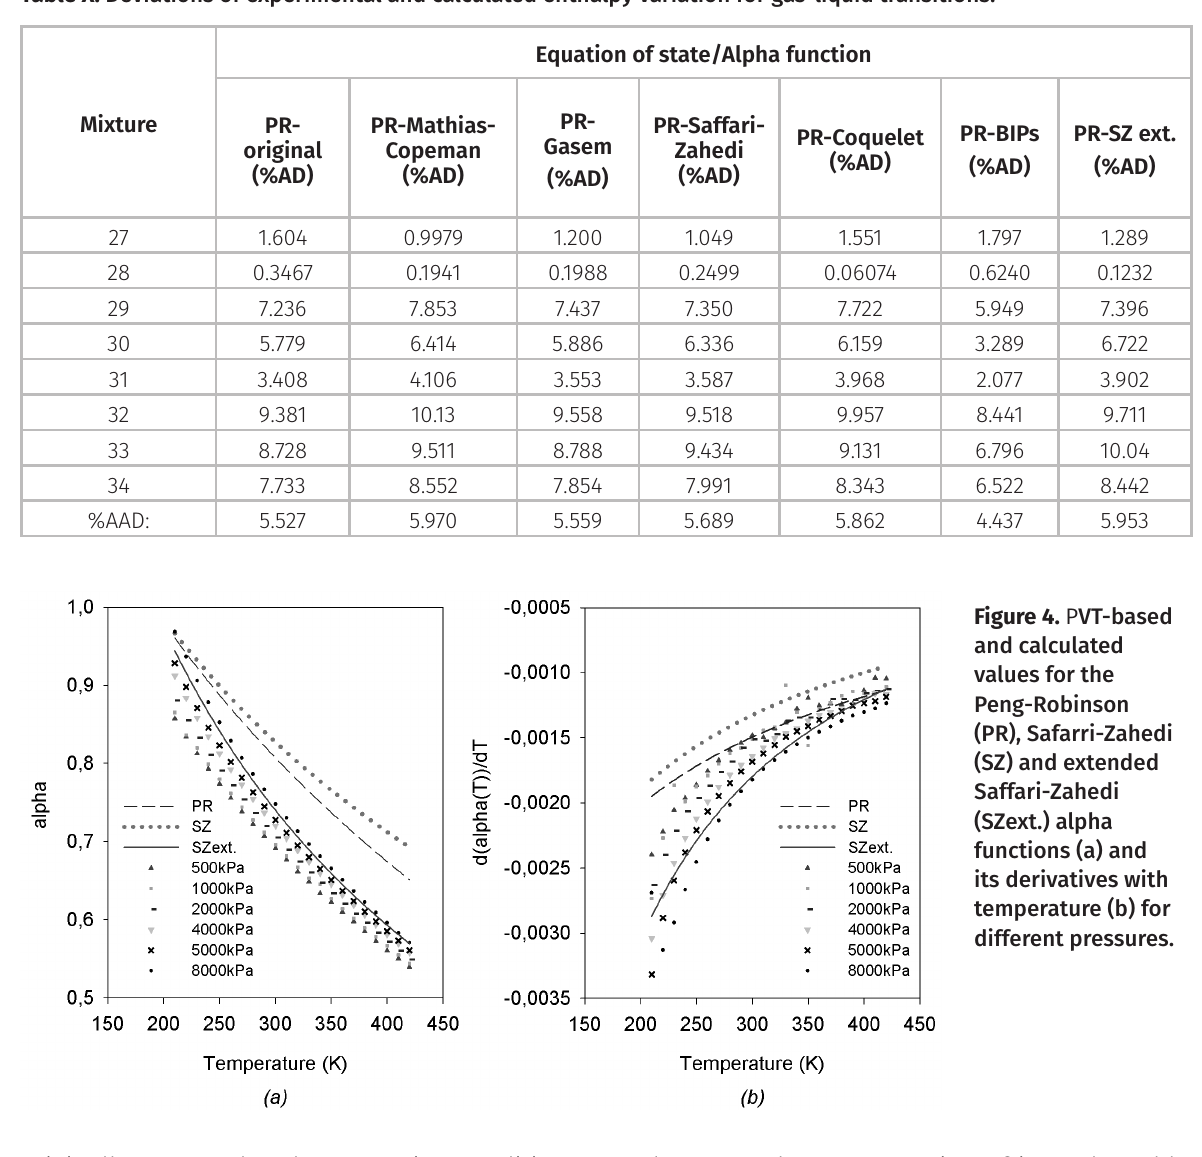
Table X. Deviations of experimental and calculated enthalpy variation for gas-liquid transitions. Mixture